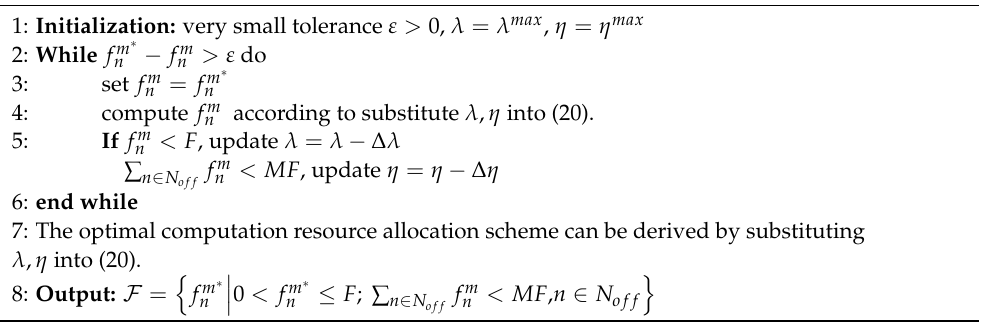
Algorithm 1: MEC computing resource allocation